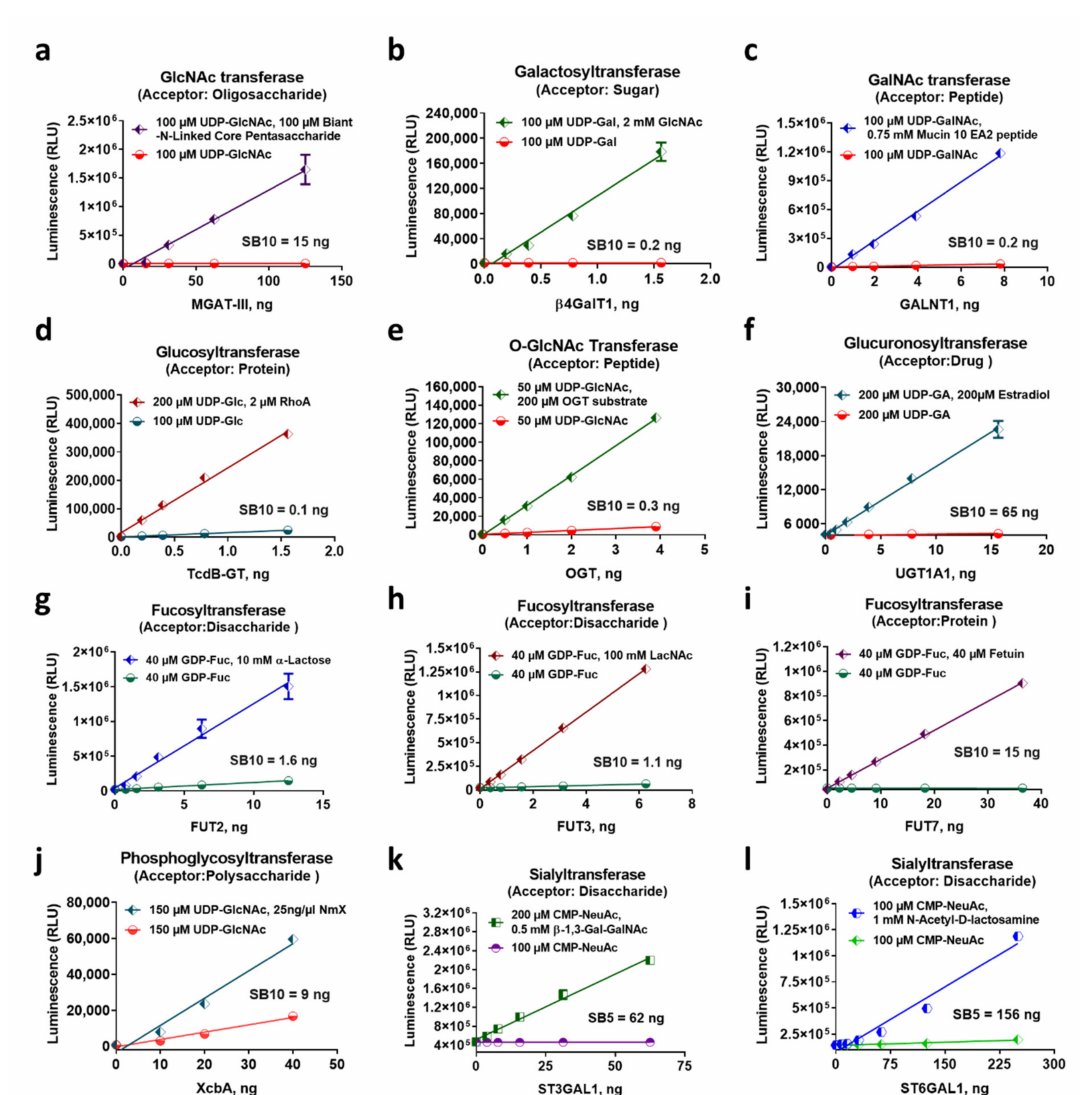
Figure 4. Universality of bioluminescent nucleotide assays towards glycosyltransferases. Enzyme titrations of representative members of each of the nucleotide forming GT subfamilies in the presence of the activated sugars and in the presence or absence of the indicated acceptor substrates of different chemical structures. ( a – f ) UDP detection in glycosyltransferases using UDP sugars. ( g – i ) GDP detection of fucosyltransferase activities using GDP-fucose. ( j ) Detection of UMP in the phosphoglycosyltransferase XcbA reaction using UMP/CMP-Glo. ( k – l ) Detection of sialyltransferase activity with UMP/CMP-Glo. Reactions were performed in duplicates. Results shown are means ± standard deviations. Names of the GTs used are indicated on the x